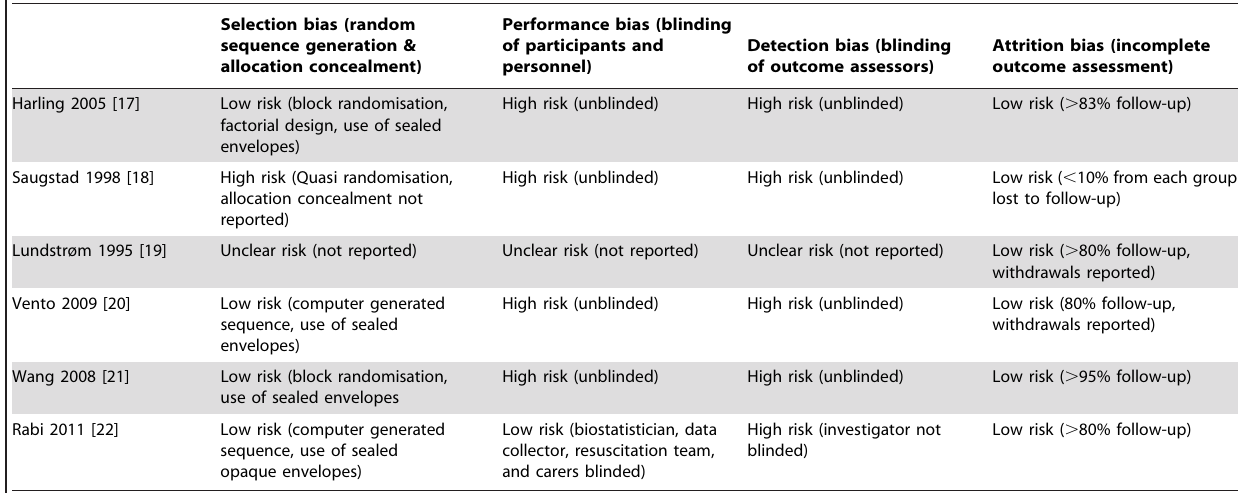
Table 4. Risk of bias assessment of included trials.